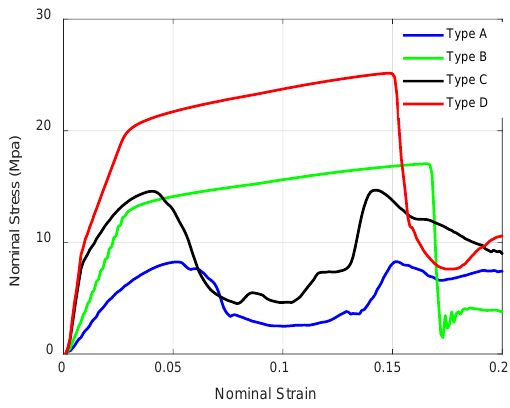
Figure 24. Nominal stress-strain curves of NPR lattice structures.